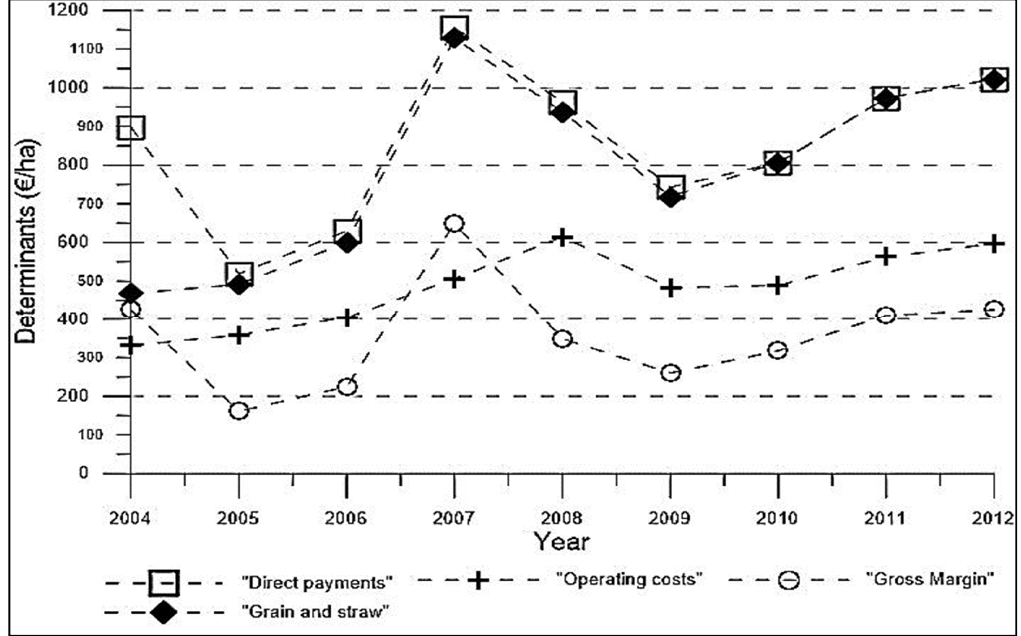
Figure 5. Farm determinants of accountancy (The European Commission, 2014).